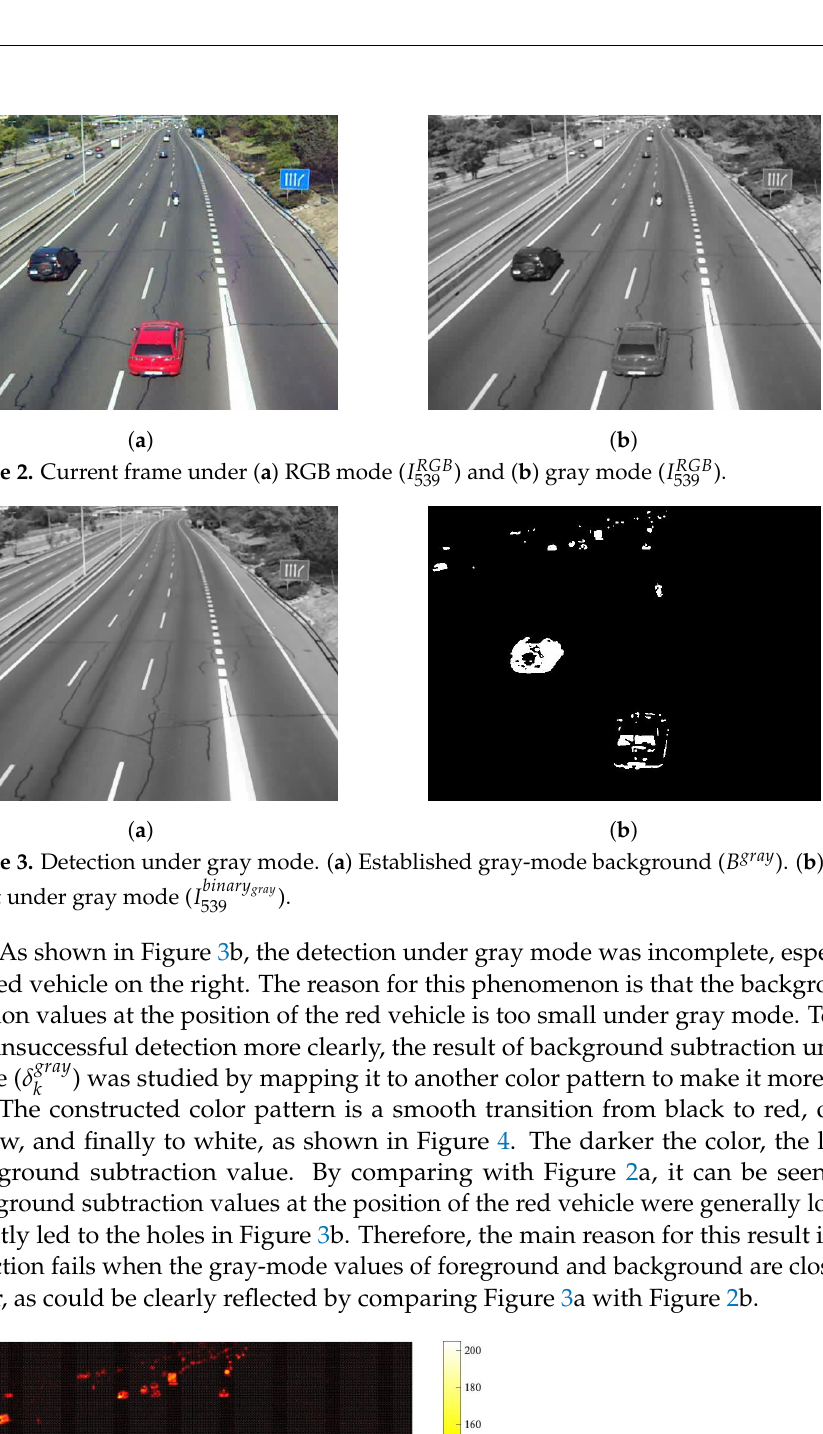
Figure 2. Current frame under ( a ) RGB mode ( I RGB